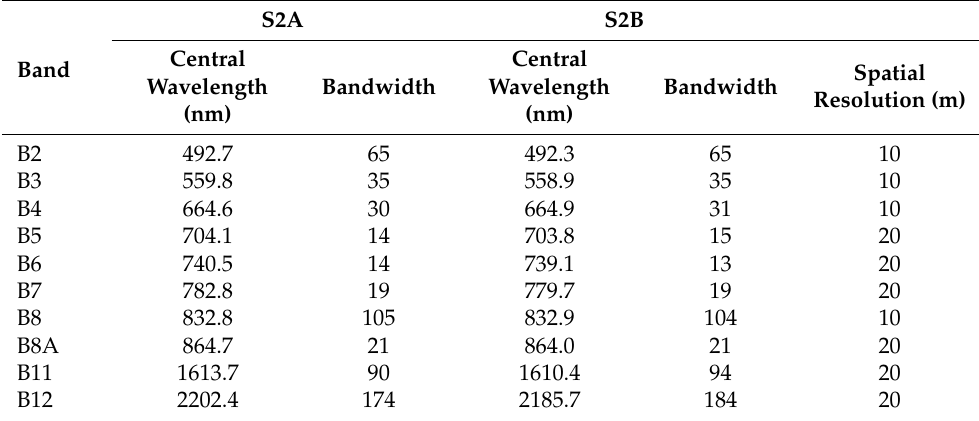
Table 1. Sentinel-2 MSI band characteristics of both S2A and S2B defined by ESA (European Space Agency) at 10 m and 20 m spatial